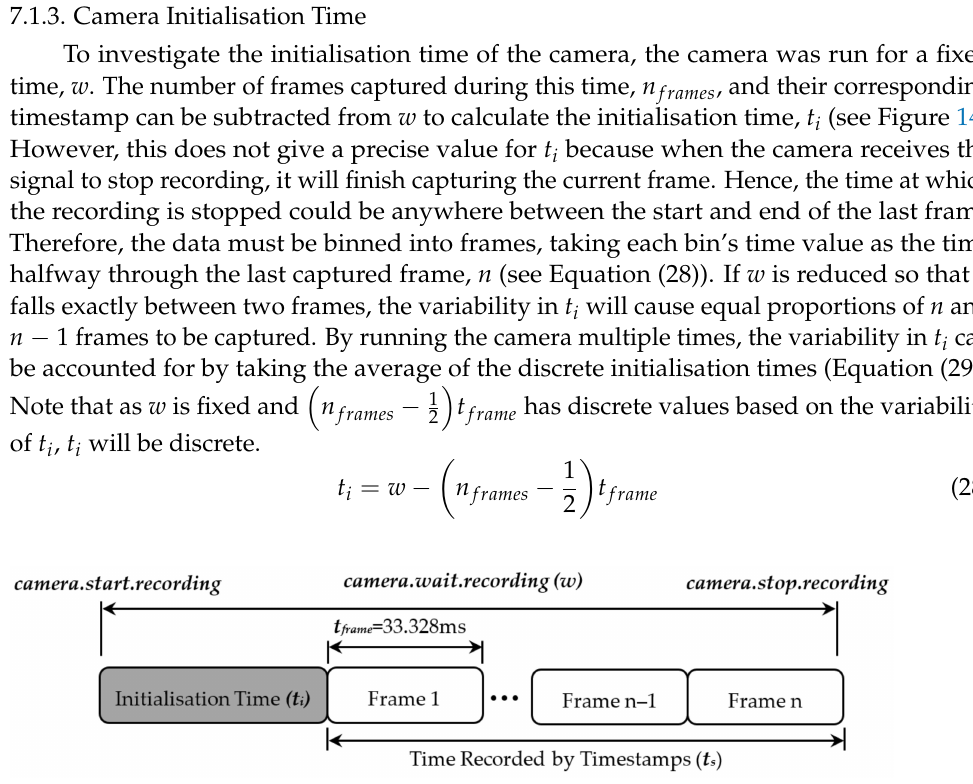
Figure 14. Optical tracking initialisation